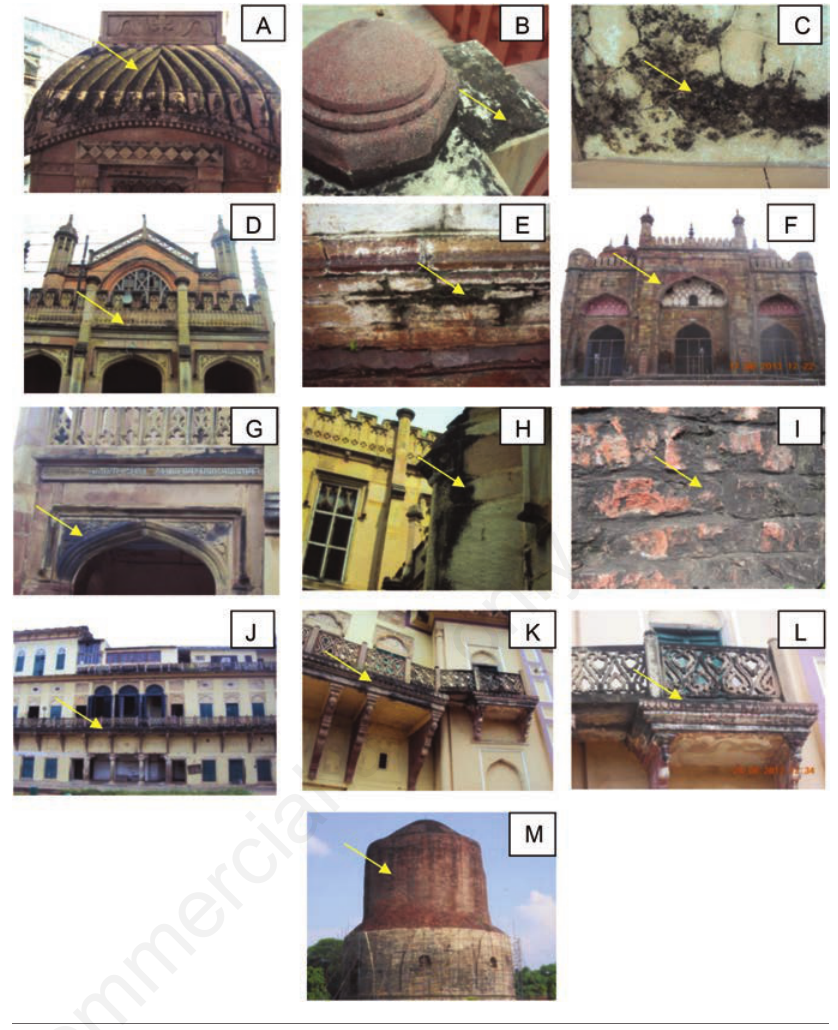
Figure 2. Historical monuments of Varanasi, India, showing surface colonization of cyanobacteria. (A) Brahaspati Temple, (B) Vishwanath Temple, BHU, (C) Bharatmata